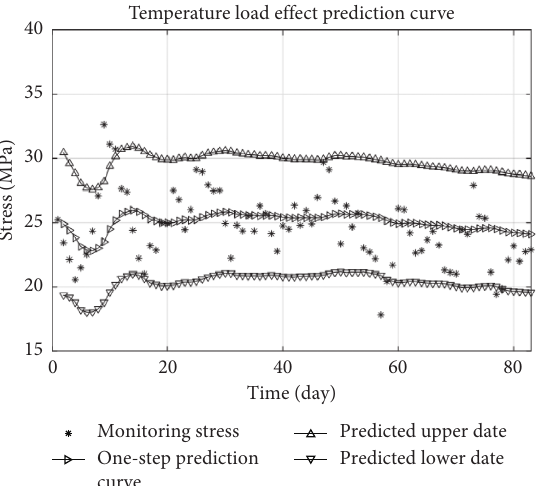
Figure 4: Predicted temperature load effects.